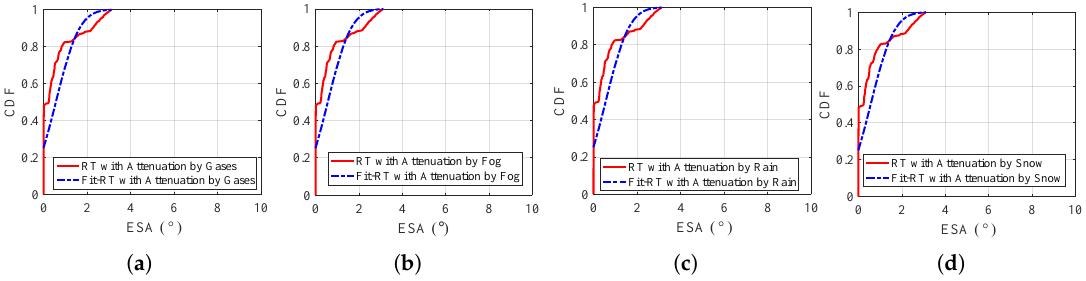
Figure 11. ESA (elevation angular spread of arrival), ( a ) by Gases; ( b ) by Fog; ( c ) by Rain; ( d ) by Snow.